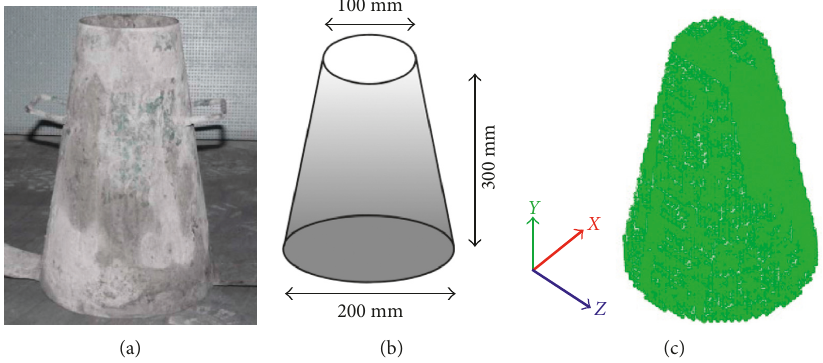
Figure 3: Slump test. (a) Experiment setup [24], (b) model size, and (c) LBM discretization.